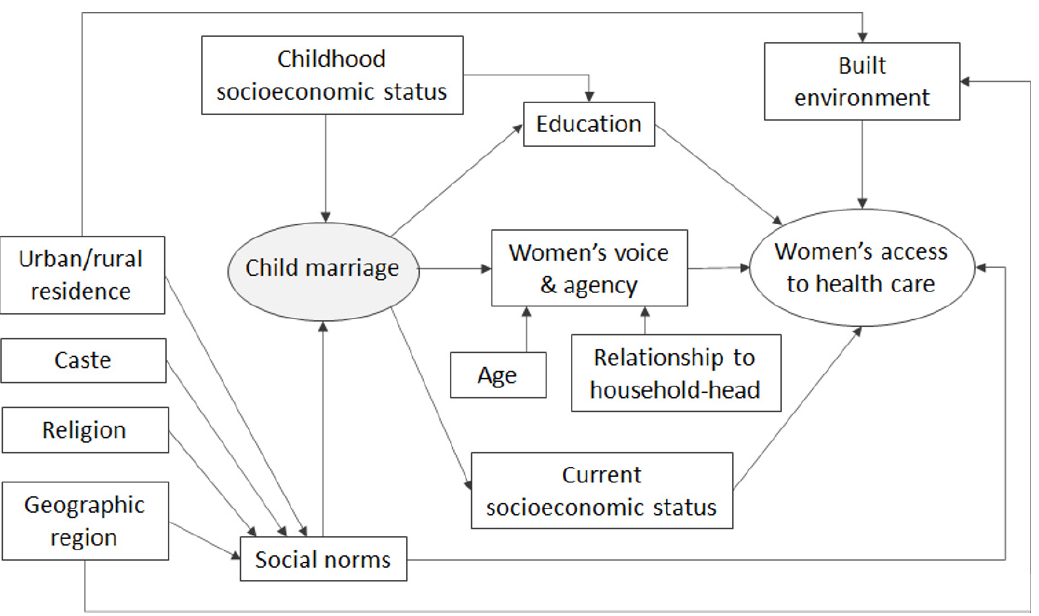
Figure 1. Conceptual framework of the relationship between child marriage and women’s access to healthcare.